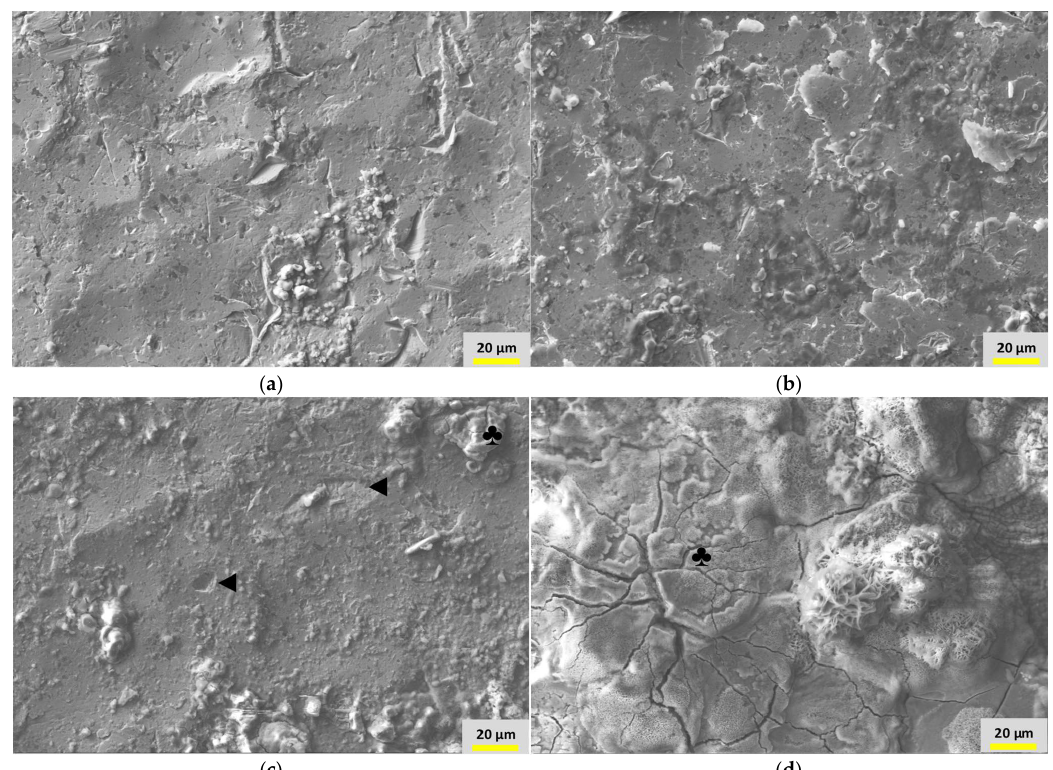
Figure 13. SEM photographs of carbon steel samples in position P2 at 32 days ( a ), 74 days ( b ), 120 days ( c ), and 241 days ( d ) of exposure.